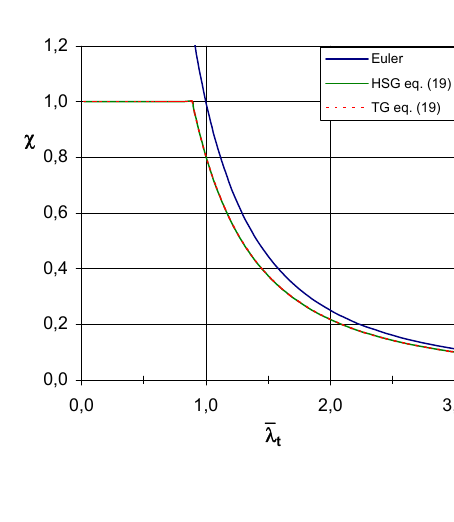
Figure 4: Consistent buckling curves for monolithic glass panes with heat strengthened and tempered glass sections according to equation